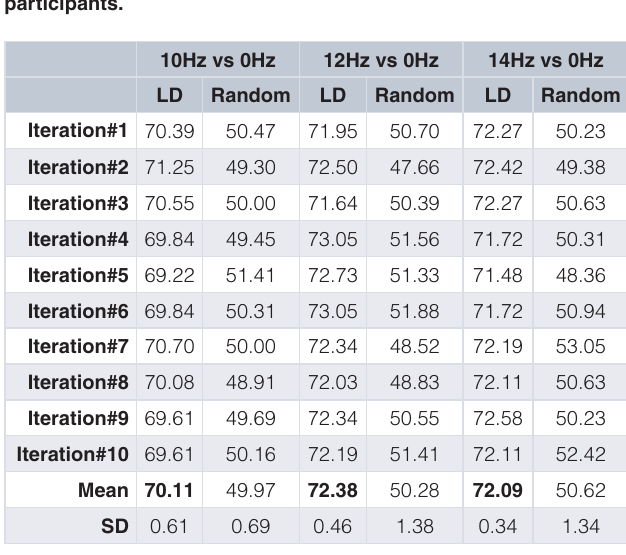
Table 4. Percentages of classification accuracies between the periods of stimulation and non-stimulation for the stimulated participants.